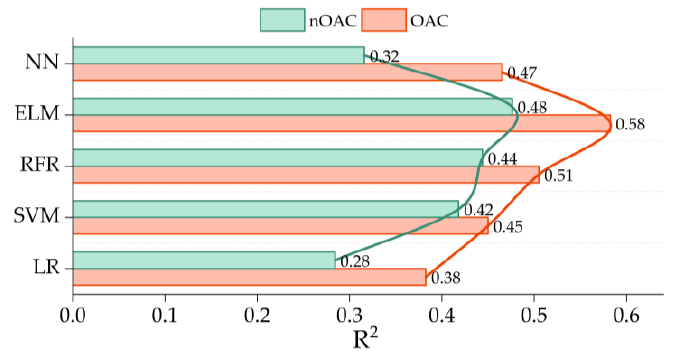
Figure 9. Average R 2 for all the models by the nature of the target parameters. OAC: Chl-a, TURB, TSM and SDD. nOAC: DO, PTOT, NO3-N, BOD and COD.